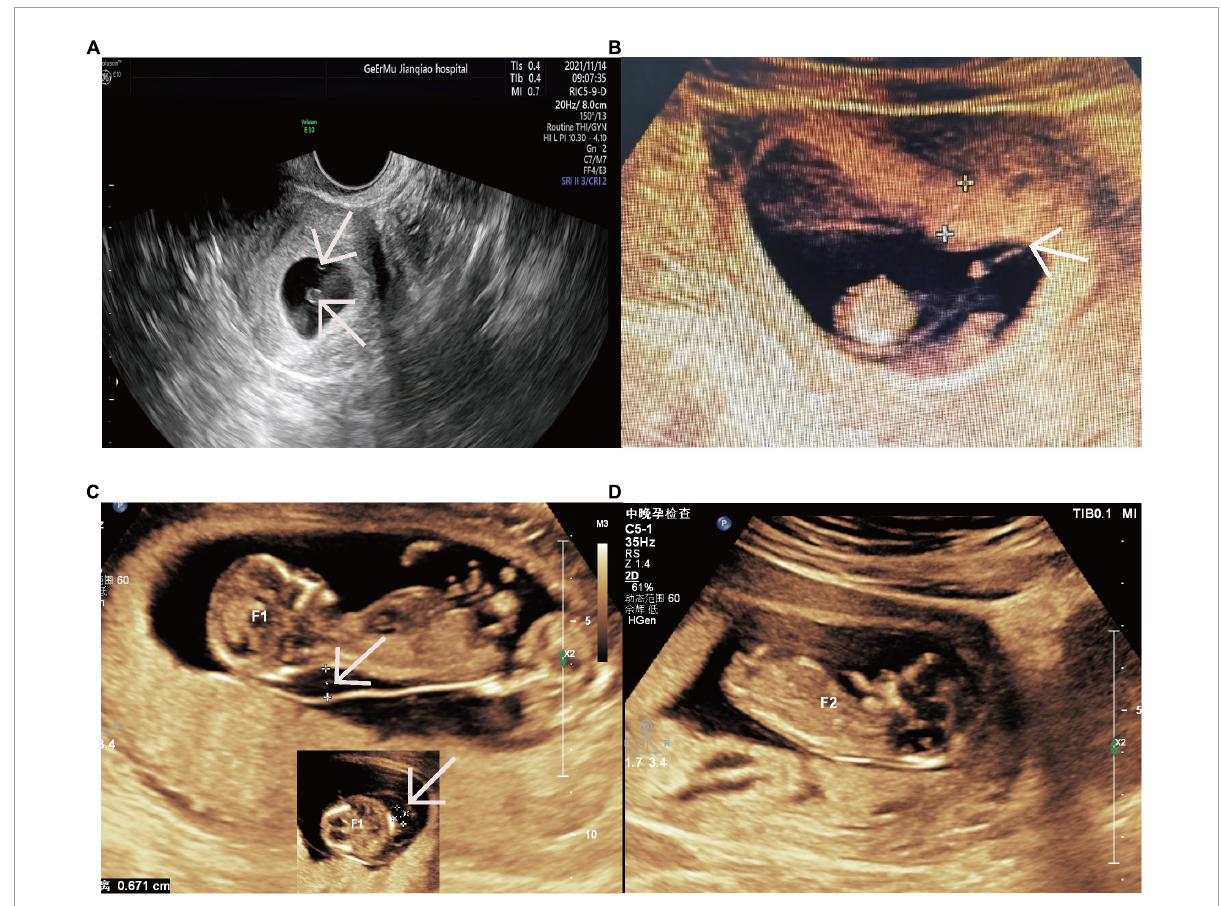
FIGURE1 Ultrasound images revealing the monochorionic twins and twin A’s nuchal cystic hygromas and twin B’s normal NT. (A) Two yolk sacs within a single gestational sac at 6 + 2 weeks. The arrow indicates two yolk sacs. (B) The monochorionic diamnitic twins with a separating membrane of T sign at 10 + 3 weeks. The arrow indicates the distinct T sign of the separating membrane between the twins. (C) Nuchal cystic hygromas of twin A at 12 + 3 weeks. The arrows indicate the nuchal cystic hygromas of twin A from longitudinal section and transverse section. (D) The normal NT of twin B at 12 + 3 weeks. NT, nuchal